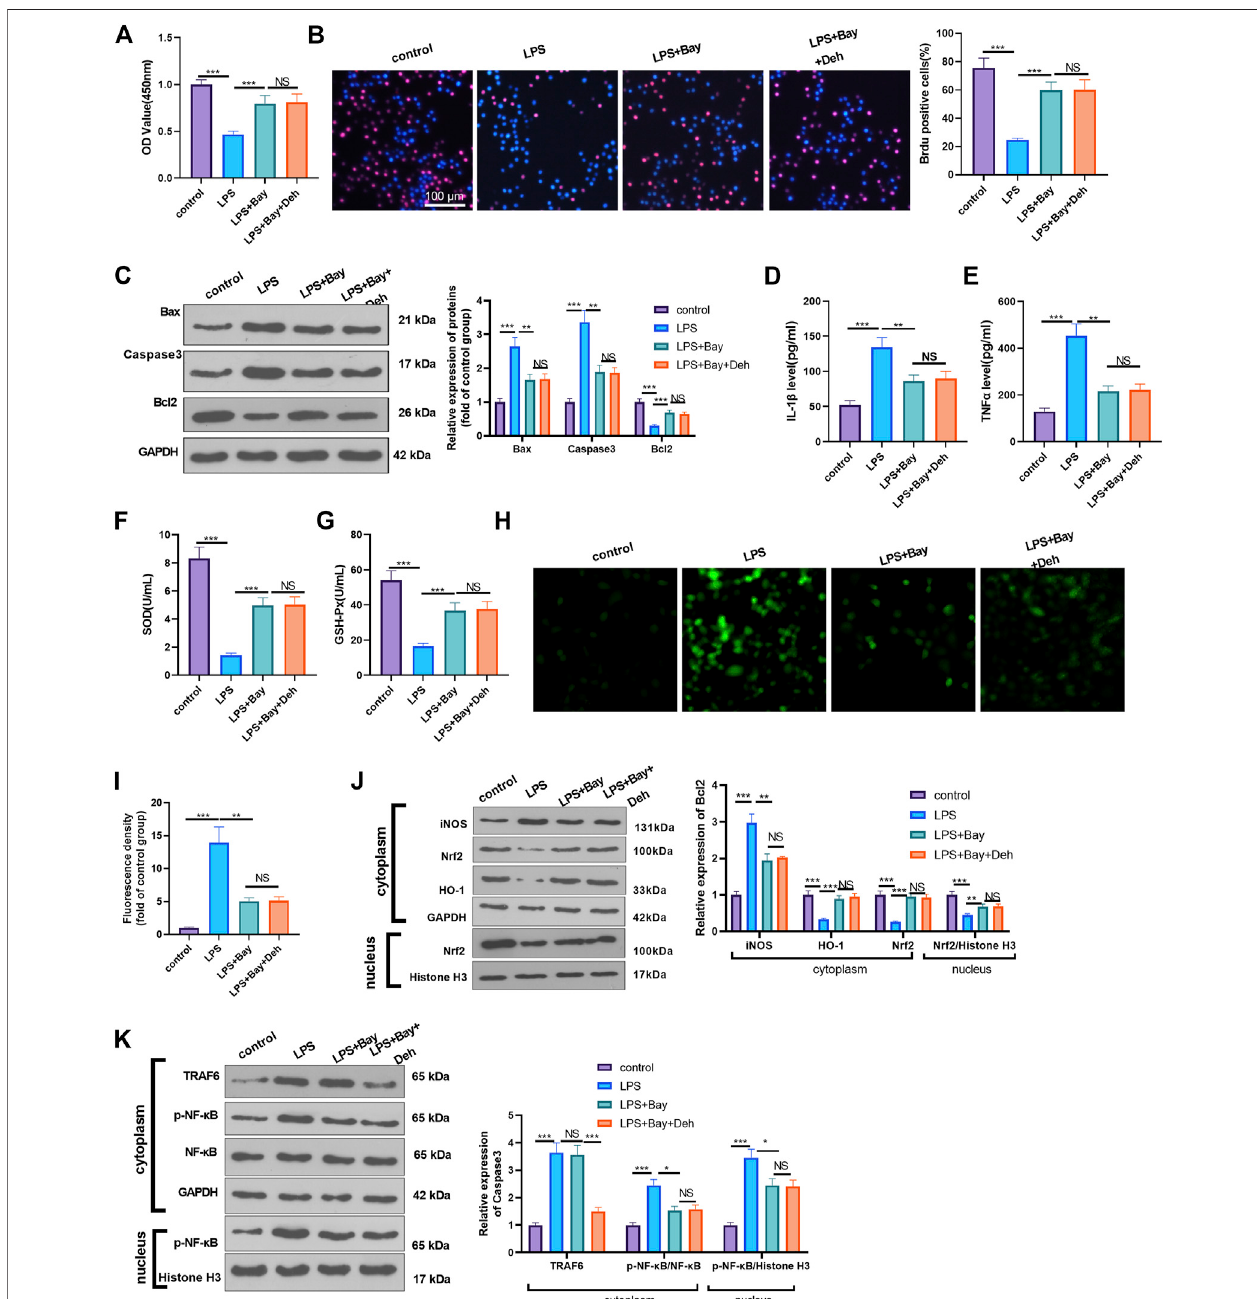
FIGURE6| InhibitionofNF- κ BattenuatedLPS-mediatedmyocardialinjury.TheH9C2cardiomyocyteswerepretreatedwithBAY11-7082(BAY,1 μ M,aninhibitor ofNF- κ B)for2 handthentreatedwithLPS(10 μ g/ml)andDeh(10 μ g/ml)for24 h (A,B) CCK8,andBrdUassayweretakentodetectthecellviabilityofeachgroup.The rate of BrdU positive cells (red)/nucleus (blue) was calculated. (C) Western blot was performed for the detection of Bax, Caspase3 and Bcl2 expressions in cardiomyocytes. (D, E) ELISA method was employed to evaluate IL-1 β and TNF α levels in the culture medium of each group. (F, G) The SOD and GSH-PX detection kits were applied to detect SOD (G) and GSH-PX (H) levels in the culture medium of each group. H-I. The ROS level in H9C2 cells were evaluated using the DCFDA/H2DCFDA — Cellular ROS Assay Kit. (J, K) . The protein level of iNOS, Nrf2/HO-1, TRAF6, and p-NF- κ B in the whole cell or nucleus of heart was detected by western blot. nsP > 0.05, * p < 0.05, ** p < 0.01, *** p < 0.001. N (cid:1) 3.